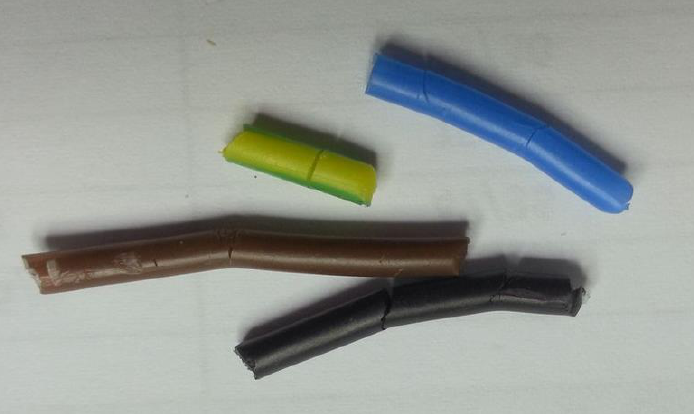
Figure 5. Appearance of cracks in XLPE insulations (IC1 cable) after three years of irradiation in SPS.